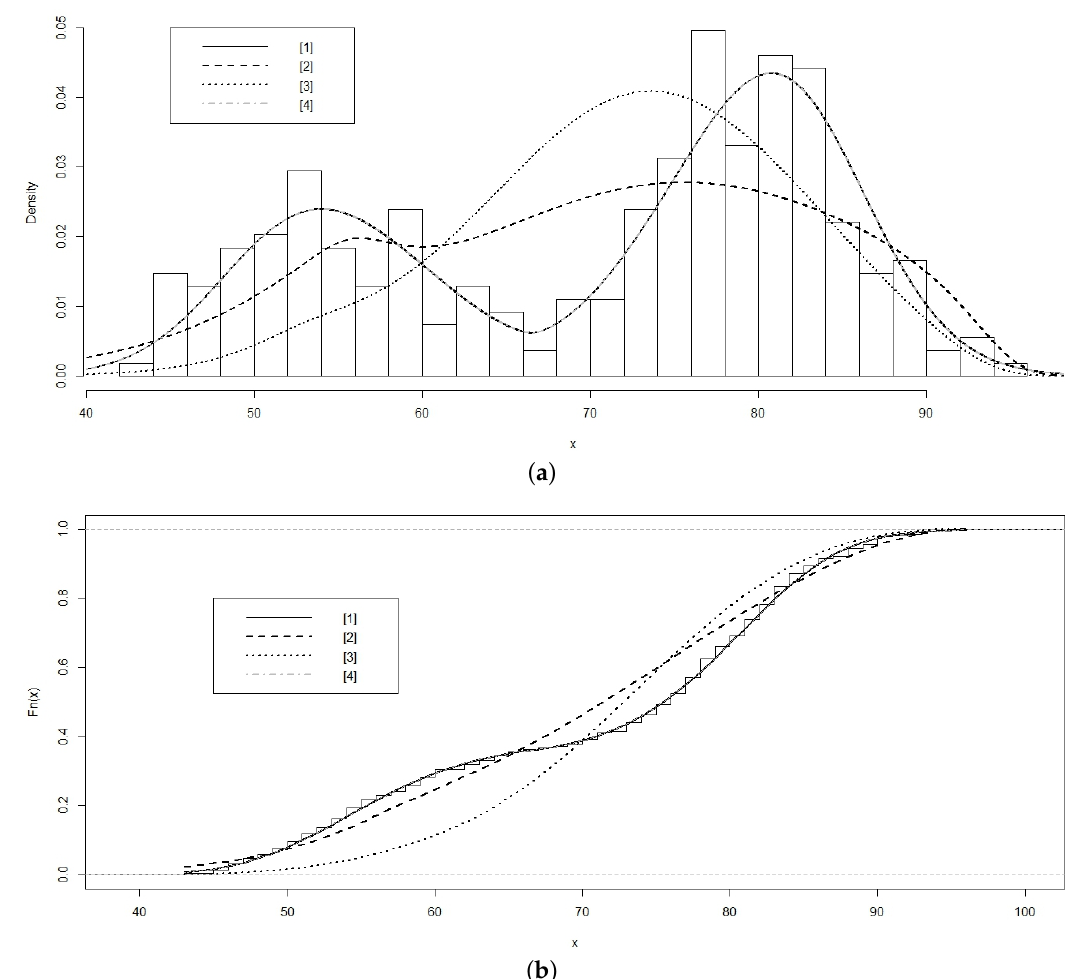
Figure 9. Faithful data - Fitted distributions. [1] Skew GL-Normal distribution; [2] Skew GL- t distribution; [3] Skew Normal-GL distribution; [4] Skew t -GL distribution. ( a ) Probability density function; ( b ) Cumulative